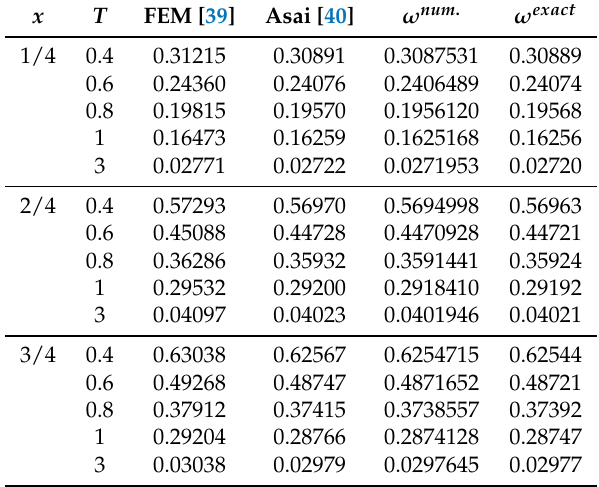
Table 2. Comparison with existing results by present results for ∆ x = 0.0125, ν d = 0.2, τ = 0.0001 at different value of T for problem 5.1.